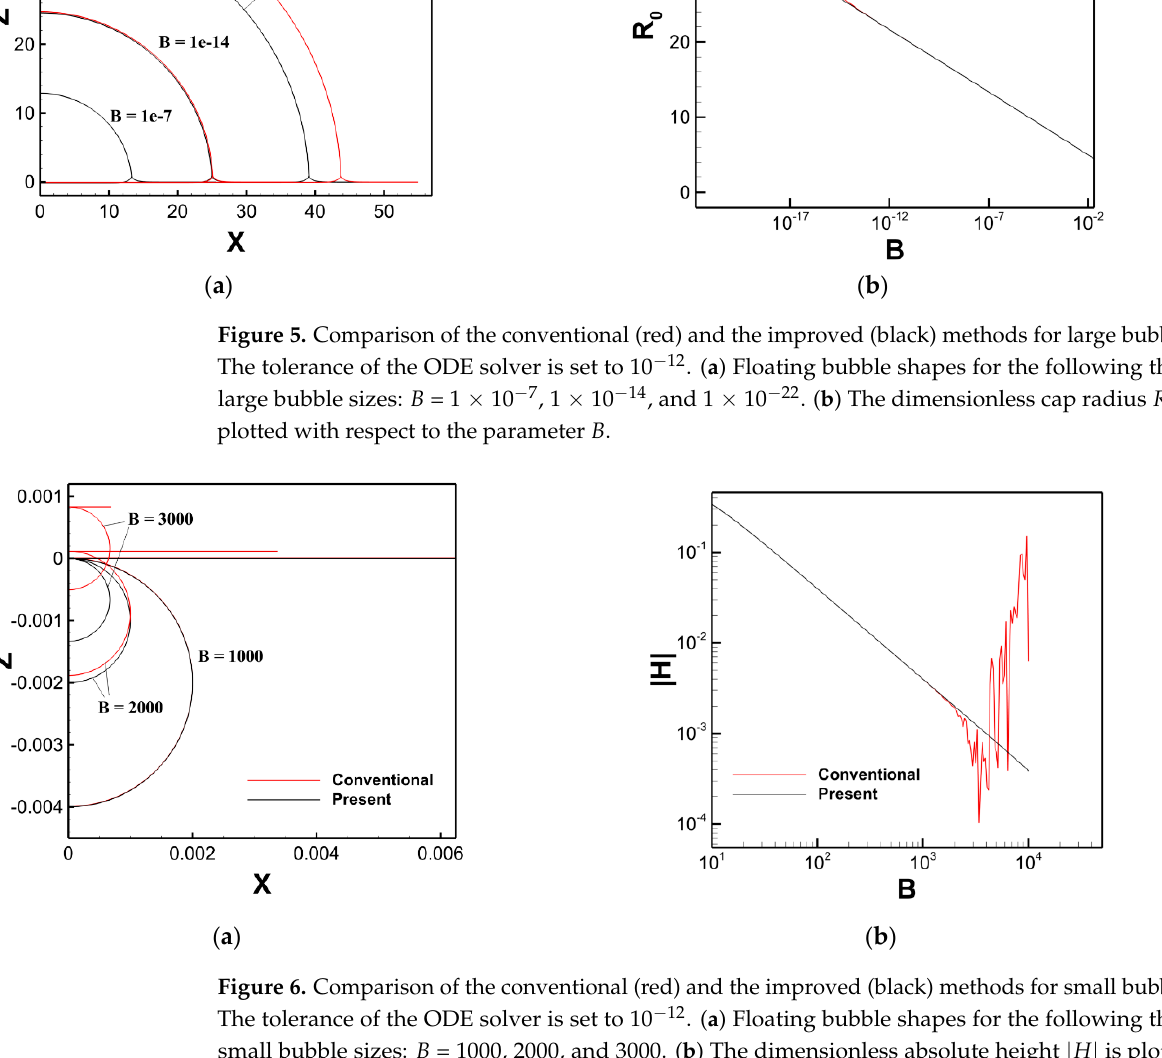
Figure 6. Comparison of the conventional (red) and the improved (black) methods for small bubbles. The tolerance of the ODE solver is set to 10 (cid:2879)(cid:2869)(cid:2870) . ( a ) Floating bubble shapes for the following three small bubble sizes: 𝐵 = 1000, 2000, and 3000. ( b ) The dimensionless absolute height |𝐻| is plotted with respect to the parameter 𝐵 .